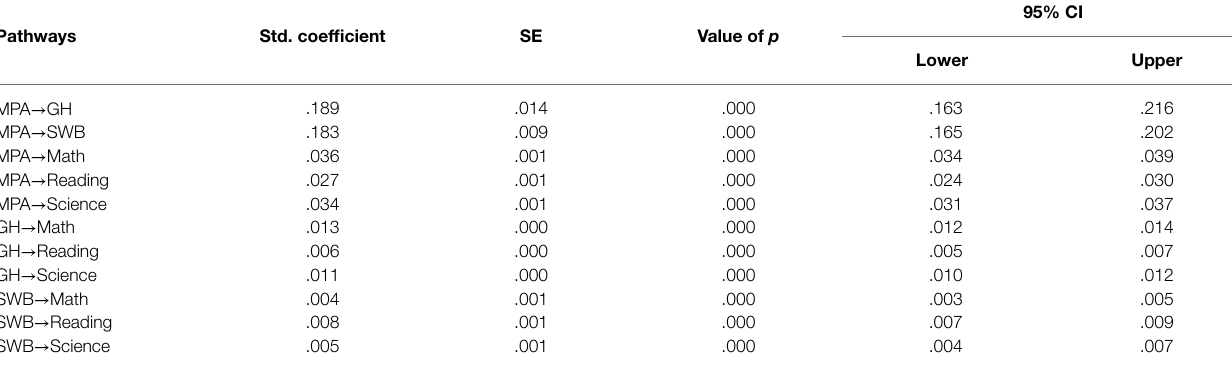
TABLE 5 | Standardized direct effects of the SEM model ( N = 63,228).